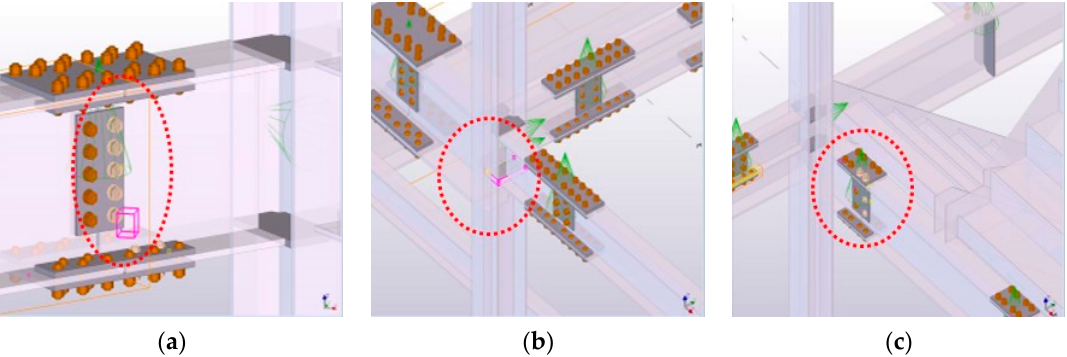
Figure 6. Clash check step applied to the BIM model: ( a ) Steel part members and bolts; ( b ) Steel part members and steel plate members; and, ( c ) Steel part members and stairs.